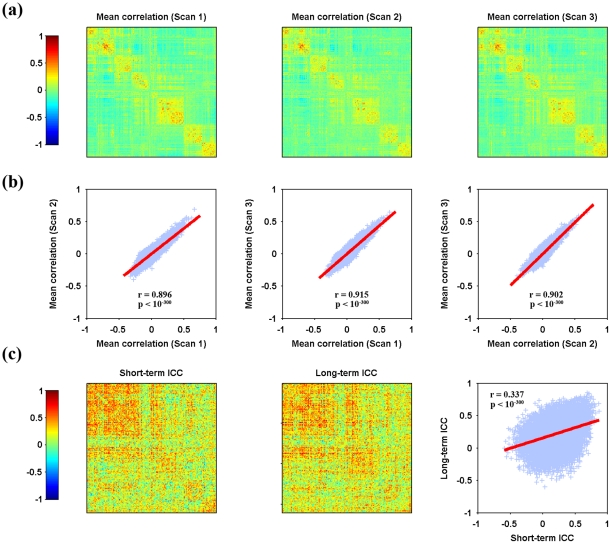
Spatial similarity and TRT reliability patterns of F-DOS-based RSFC.Mean Pearson correlation matrices (a), consistency of overall patterns between mean matrices (b) and TRT reliability of individual connections as well as the relationship between short-term and long-term reliability (c) are illustrated. The mean correlation matrices exhibited high similarity from both visual inspection (a) and quantitative spatial correlation analyses (b). Further TRT reliability analyses revealed many connections exhibiting fair to excellent reliability (c, also see Fig. 2). Moreover, a significant (p<0.05) correlation was found in the ICC matrices between short-term and long-term scans (c). No inter-hemisphere homotopic functional connections were highlighted because of the absence of direct inter-hemisphere correspondence for these ROIs. TRT, test-retest; RSFC, resting-state functional connectivity; F-DOS, functional ROIs from Dosenbach et al. (2006, 2010). Of note, the functional ROIs were listed as in Table S3.